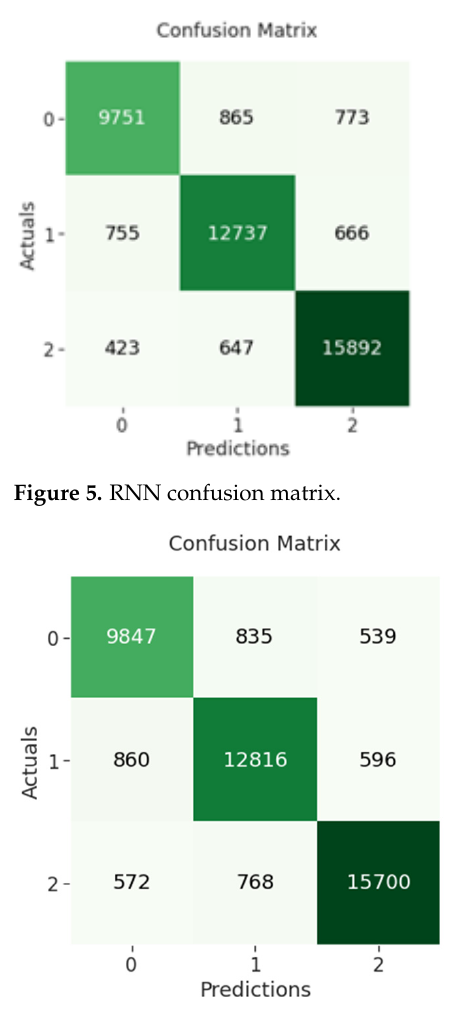
10 of 14 Figure 4. CNN confusion matrix.